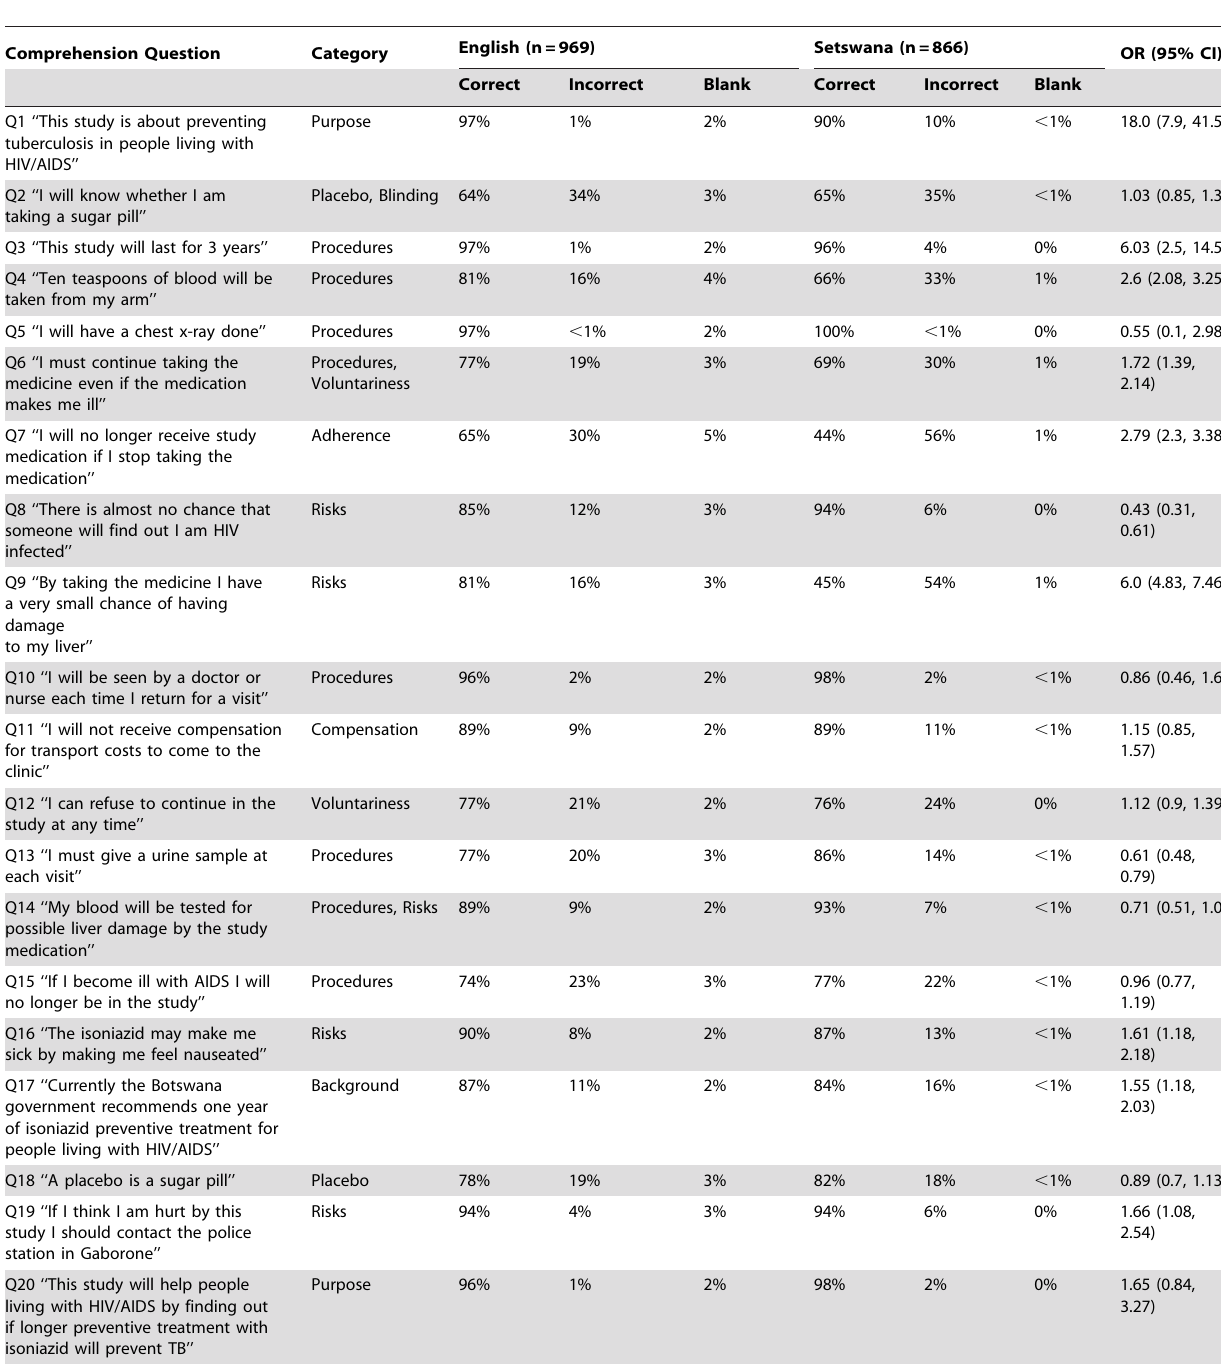
Table 6. Proportion of participants answering comprehension quiz 1 questions 1–20 correctly (English & Setswana); Odds of answering correctly if quiz taken in